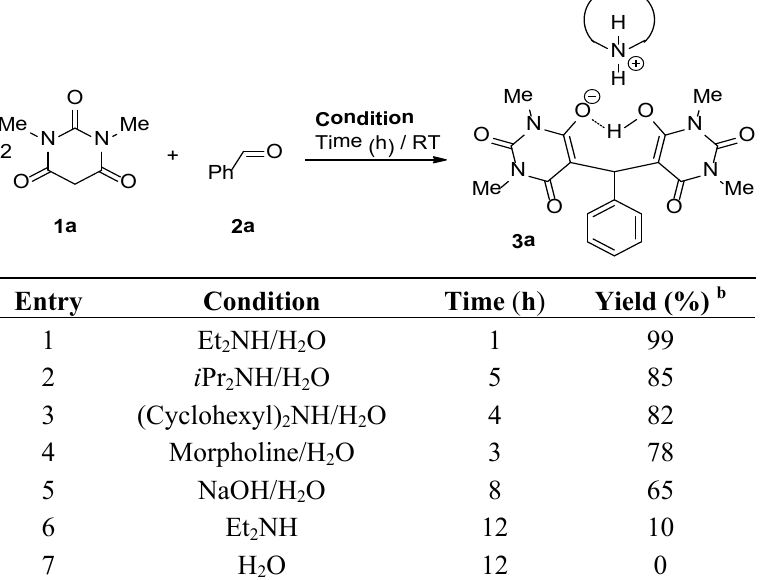
Table 1. Screening of conditions for the Aldol-Michael addition reaction of model substrate a .